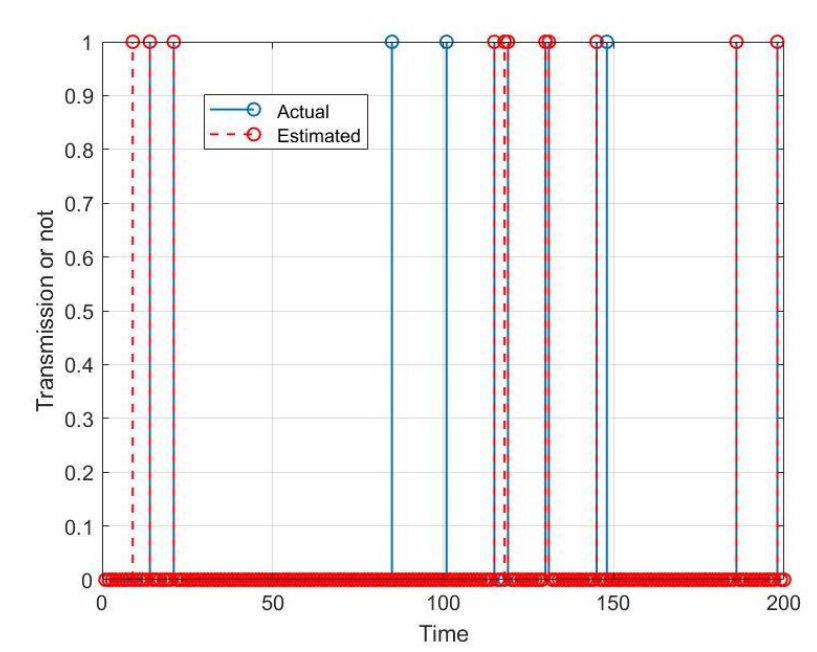
Figure 12. Number of successes vs. channel